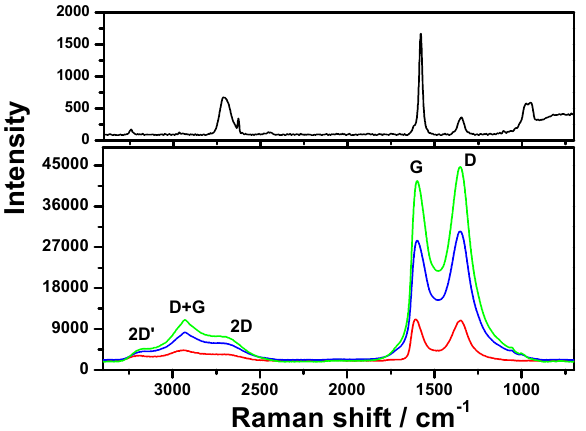
Figure 2. Raman spectra of graphite (top figure); GO (red curve), GO-AgNPs (green curve), and NIF@GO-AgNPs (blue curve) in the 3400–700 cm − 1 range.